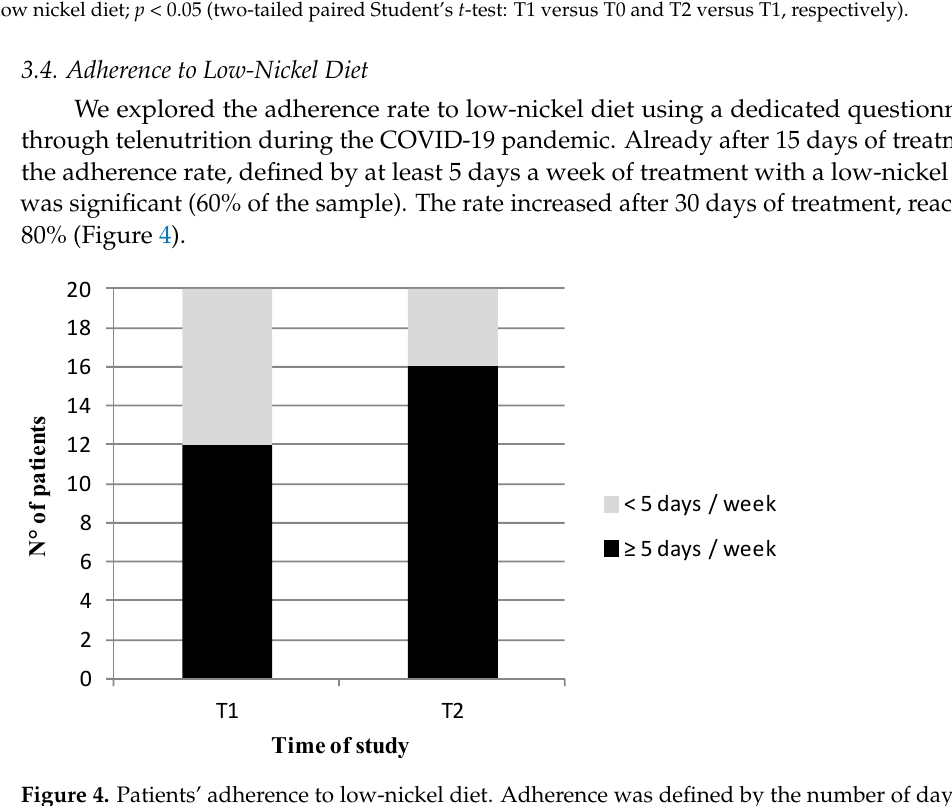
Table 4. Anthropometric findings at baseline, after 15 days and at the end of the study.